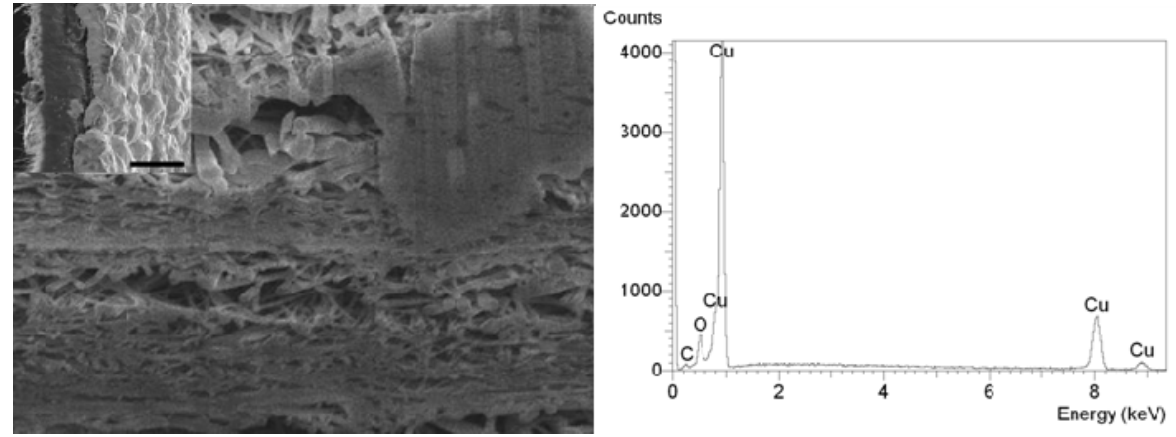
Figure 3. Focus ion beamed cross section of a copper plated BP. Left image (insert) shows that copper is present on the surface, while the main SEM image shows that aggregates of copper are being formed within the pores of the structure as demonstrated by the EDS analysis. The scale bars respectively correspond to 10 μ m for the insert and 1 μ m for the main